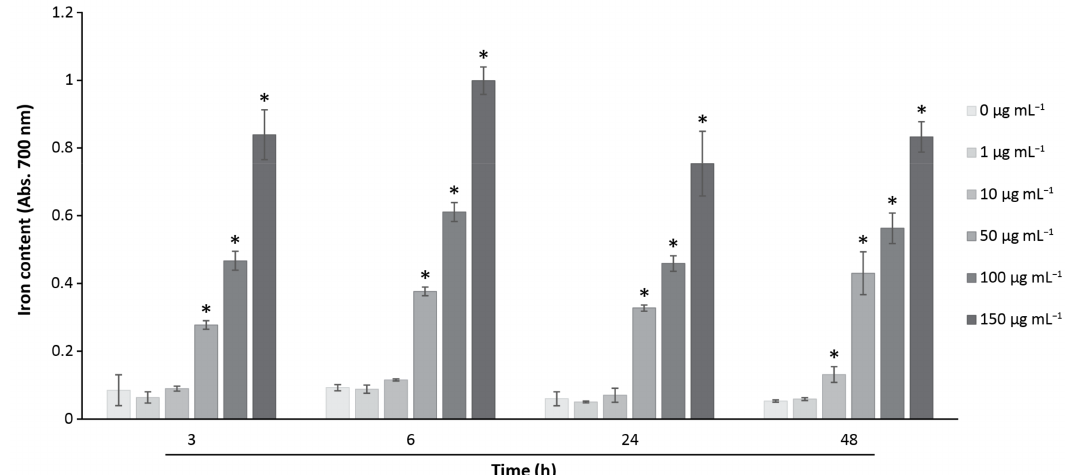
Figure 6. Iron quantification of MAG.PEG . The vGPCR cells were incubated with different concen- trations of MAG.PEG (1–150 µ g mL − 1 ) or distilled water as control in settled periods of time (3–48 h). The iron content was determined by Prussian blue assay and the colored product was measured at 700 nm. The data is presented as mean ± SD in a bar graph. Kruskal–Wallis followed by the Mann–Whitney U test was performed, and the statistically significant differences between control and MAG.PEG conditions are indicated as: * p < 0.05. N = 4.